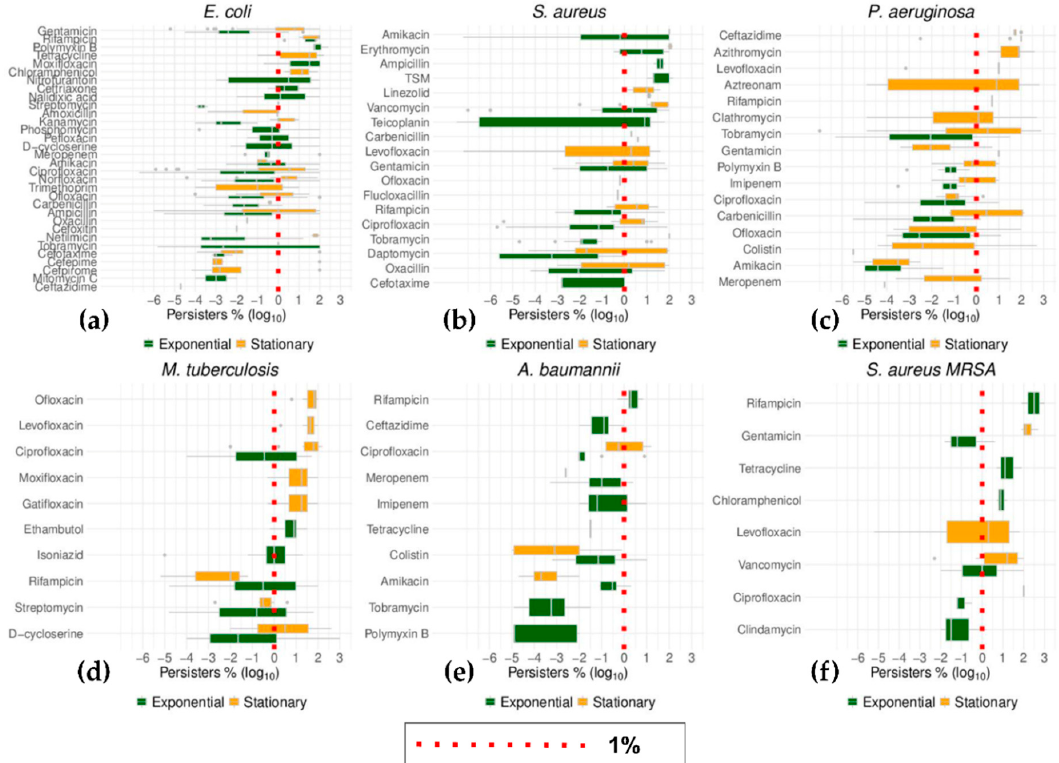
Figure 10. Distribution of the data from the six most studied bacteria species as grouped by growth phase. The percentages (as log 10 ) of persisters to antibiotics as listed for each species were ordered by their median values. The growth phase of the cultures that underwent persistence tests were differentially plotted, green for samples from exponential cultures and orange for stationary cultures. The red dotted lines represent the position at which levels of persister cells of 1% are in each box plot. With the exception of the data for colistin in A. baumannii , the higher number of persisters found in cells from stationary cultures exemplified here in the six most commonly studied bacteria